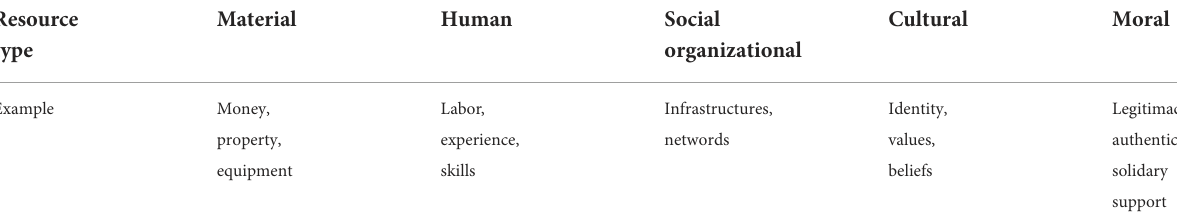
TABLE 1 Resource types as conceptualized by Edwards and Kane